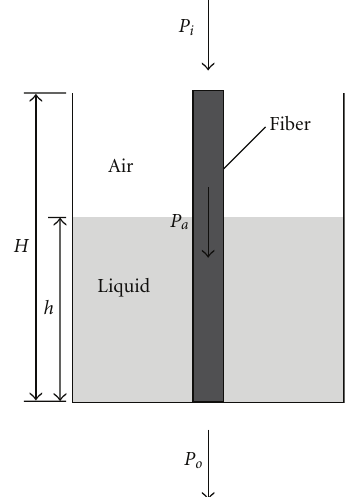
Figure 1: Schematic of a basic side-leaking OFLLS.